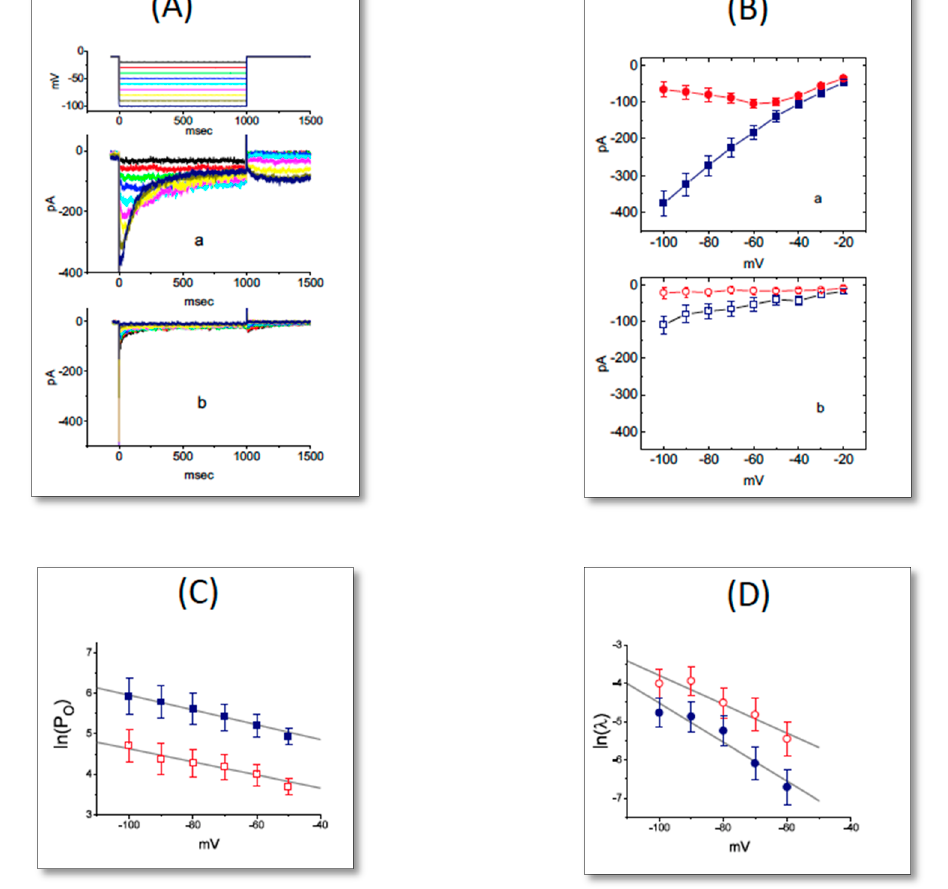
Figure 2. Effect of UCL-2077 on the I-V relationship of I K(erg) in GH 3 cells. In these experiments, we maintained each cell at − 10 mV and the 1-sec hyperpolarizing command voltages ranging between − 100 and − 20 mV were delivered. ( A ) Superimposed current traces in the absence (a) or presence (b) of 30 µ M UCL-2077. The voltage profile applied for current elicitation is indicated in the uppermost part of (A). ( B ) Averaged I-V relationships of I K(erg) in the control (a, closed symbols) and during exposure to 30 µ M UCL-2077 (b, open symbols). Current amplitudes in each panel were obtained at the beginning (square symbols) and end (circle symbols) of voltage pulses (mean ± SEM, n = 8 for each point). ( C ) Relationships of ln(P O ) versus membrane potential in the control ( ■ ) and during cell exposure ( □ ) to 30 μ M UCL-2077. The P O denotes macroscopic open probability and is reflected by the peak amplitude of I K(erg) elicited by membrane hyperpolarization. Based on equation (4), the slopes of dashed lines for the absence or presence of 30 μ M UCL-2077 were estimated to be − 0.018 or − 0.016, respectively. ( D ) Relationships of ln( λ ) versus membrane potential (see equation (5)) obtained with or without addition of 30 μ M UCL-2077. The slope indicated in straight lines for the absence ( ● ) and presence ( ○ ) of 30 μ M UCL-2077 was − 0.051 or − 0.038, respectively. 2.3. Steady-State Activation of I K(erg) Altered by the Presence of UCL-2077 To further characterize the suppressive effect of UCL-2077 on I K(erg) , we next tested the voltage dependence of the effect of UCL-2077 on I K(erg) in GH 3 cells. Figure 3 shows the steady-state activation curve of I K(erg) in the absence or presence of UCL-2077 (10 μ M). In these experiments conducted with a two-step command voltage protocol, a 1-sec conditioning pulse to different voltages was delivered to precede the test pulse to − 100 mV from a holding potential of − 10 mV. We then constructed the relationship between the conditioning potentials and the normalized amplitudes of I K(erg) and then fitted the data set with a Boltzmann function (see equation (6)). In the control, the voltage for half-